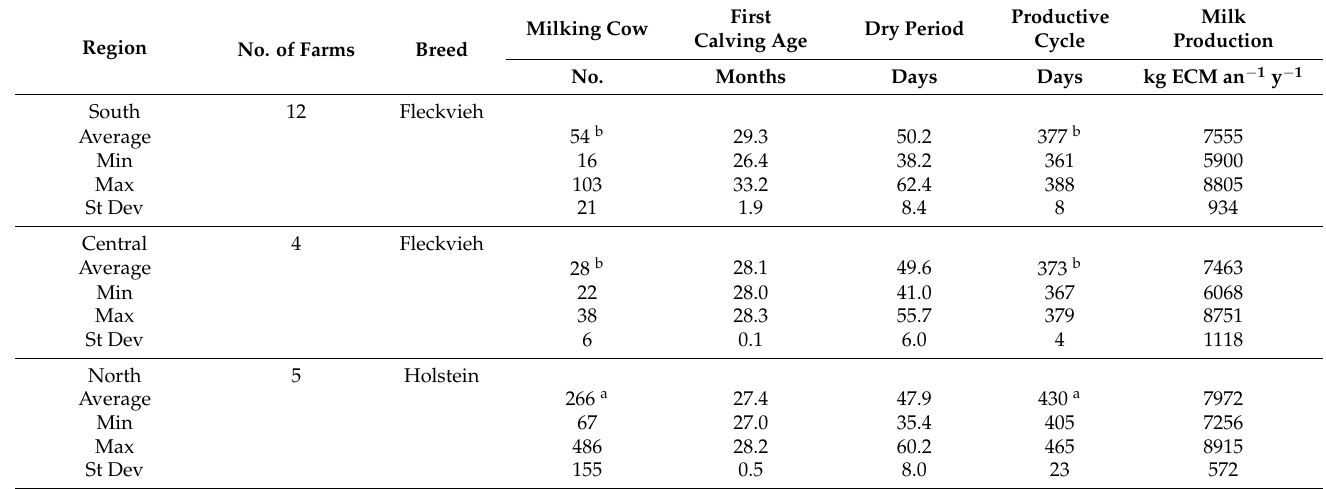
Table 4. Analysed farm descriptions: breeding systems.